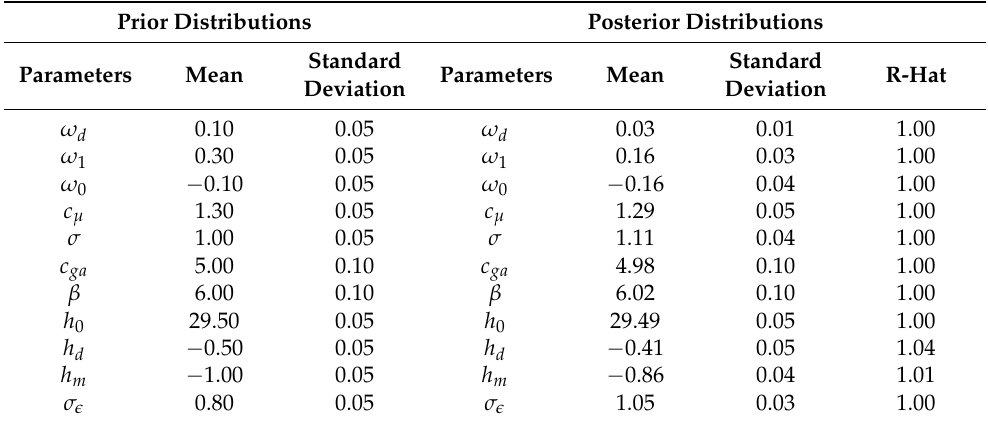
Table 2. The selected prior distributions and estimated posterior distributions of parameters. Prior Distributions Posterior Distributions Parameters Mean